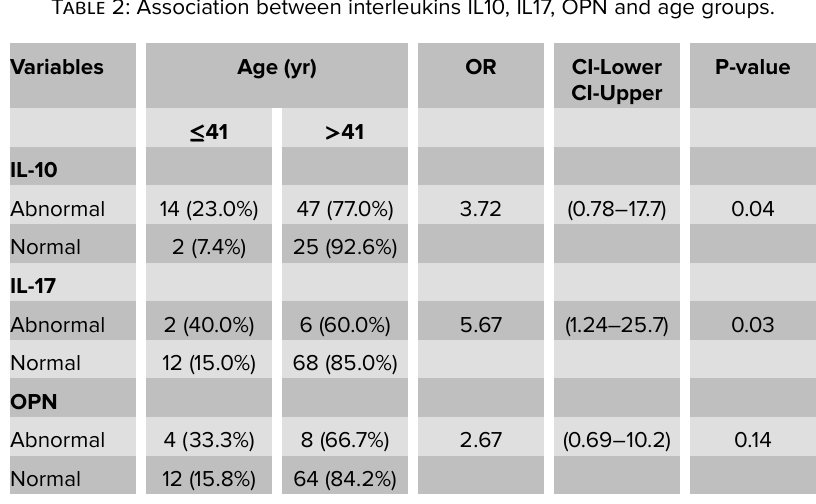
TABLE 2: Association between interleukins IL10, IL17, OPN and age